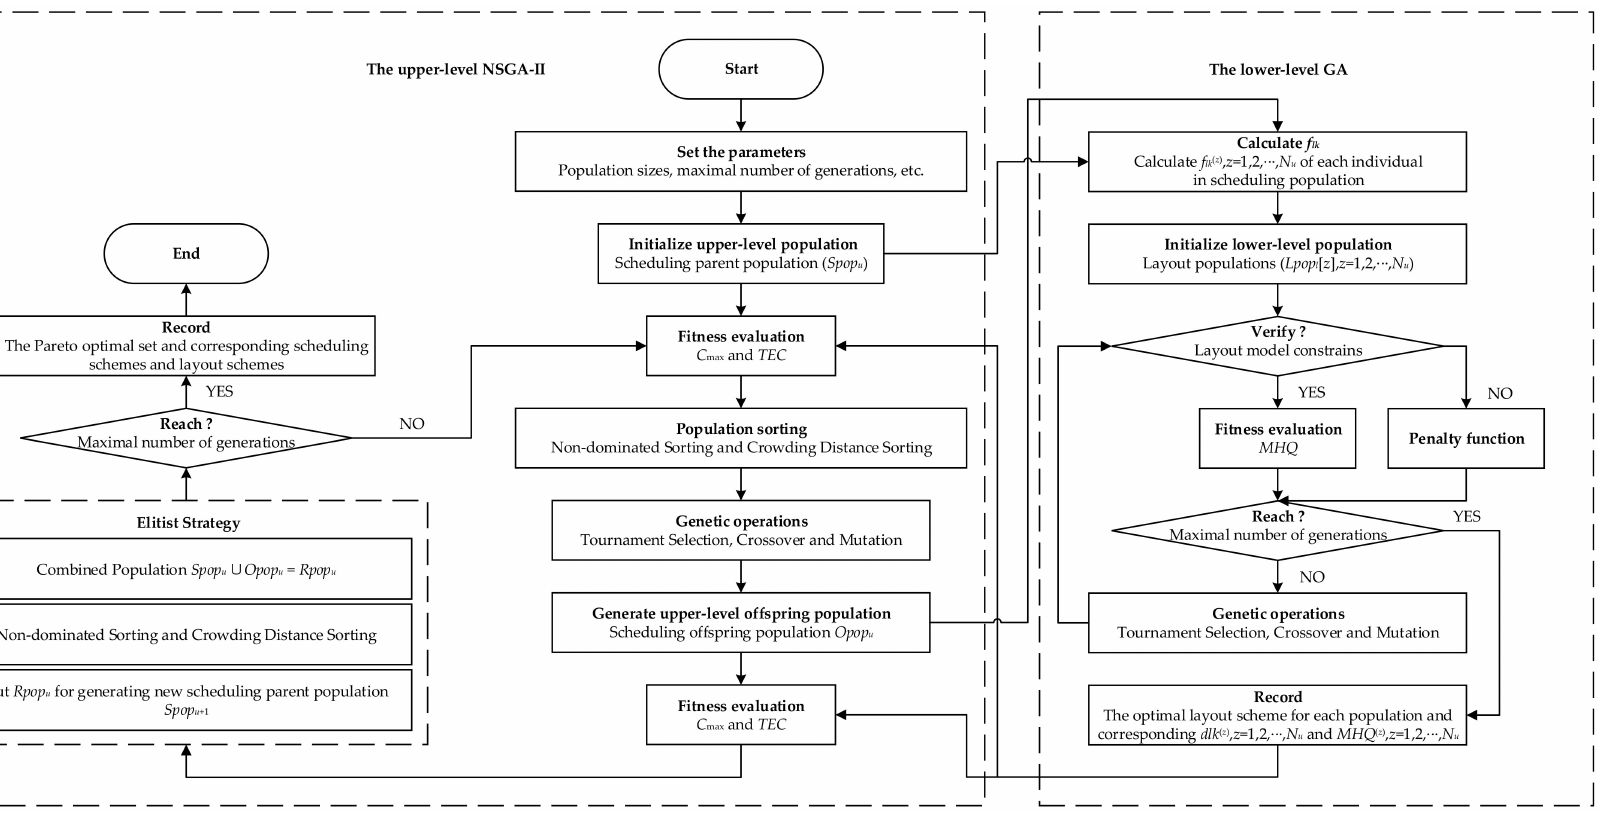
Figure 6. The flowchart of